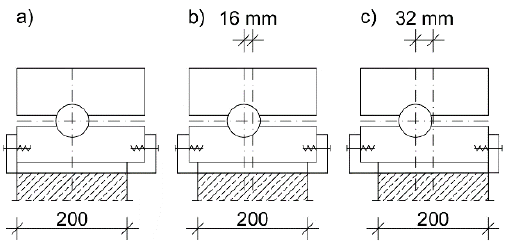
Figure 2. Cylindrical bearing used in the experiment: ( a ) e = 0; ( b ) e = 16 mm; ( c ) e = 32 mm. Table 3. Configuration of specimens [18,19].